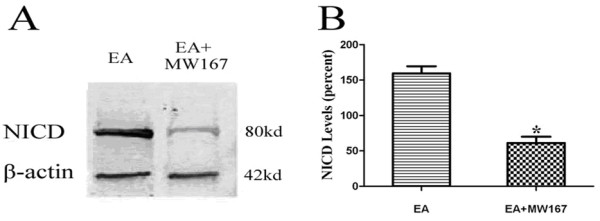
MW167 decreases the expression of Notch1 NICD in the striatum at 24 h after I/R. (A) Representative Western blot bands of Notch1 NICD (80 kDa) expression obtained from rats in EA (lane 1), EA + MW167 (lane 2) groups. (B) The bar graph shows quantification of the Western blot analysis for the Notch1 NICD protein compared with β-actin. (*P < 0.05 EA vs. EA + MW167).